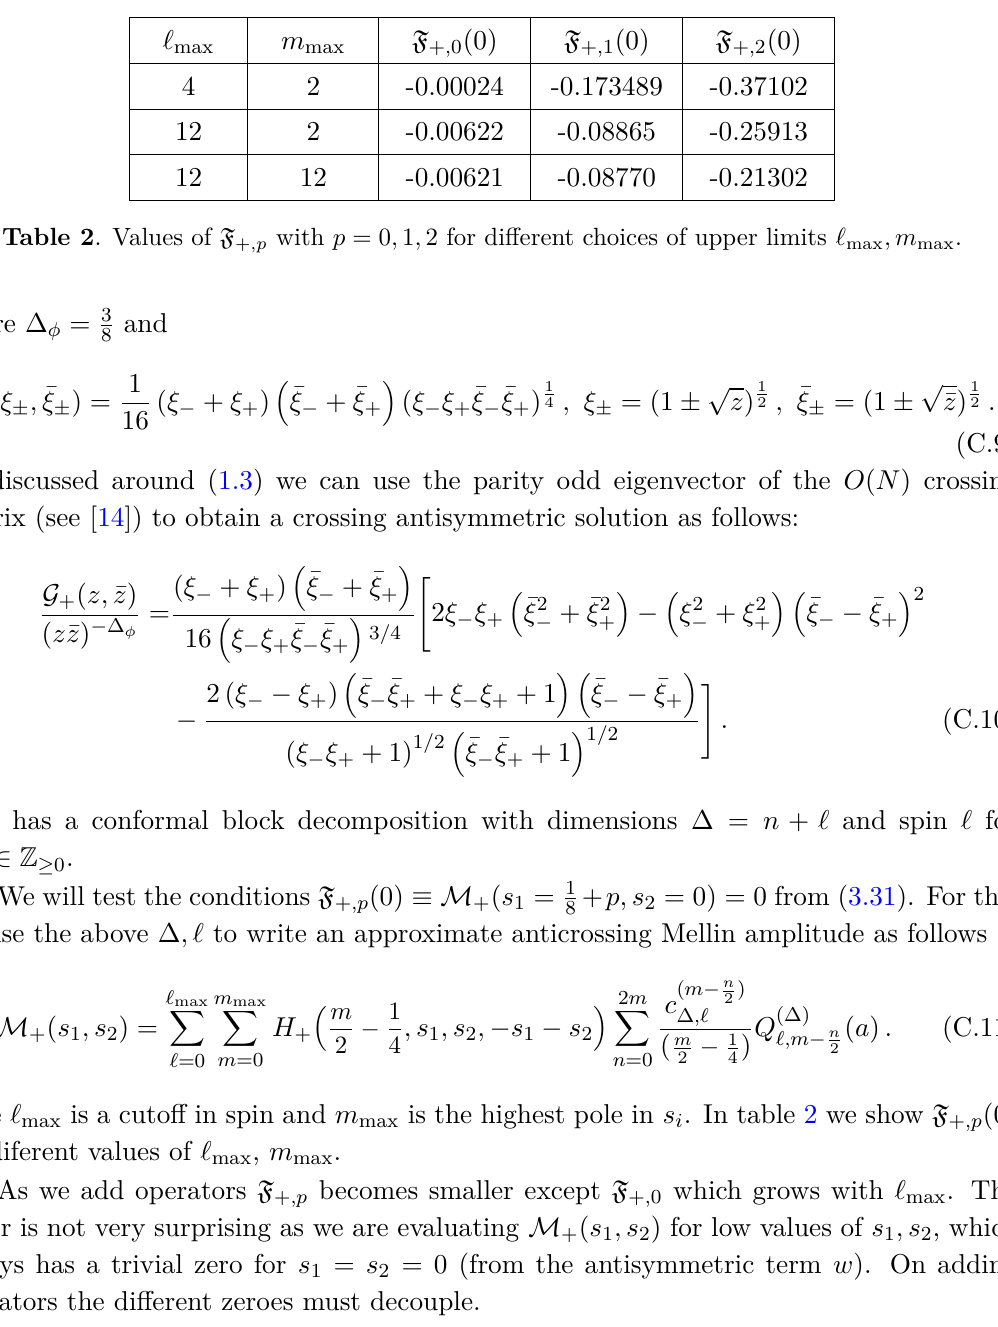
Table 1 . Comparing M 0 and M 0 for different choices of s 1 , s 2 while increasing p max and q max . 0 The s 1 , s 2 values were chosen to have a fast convergence.